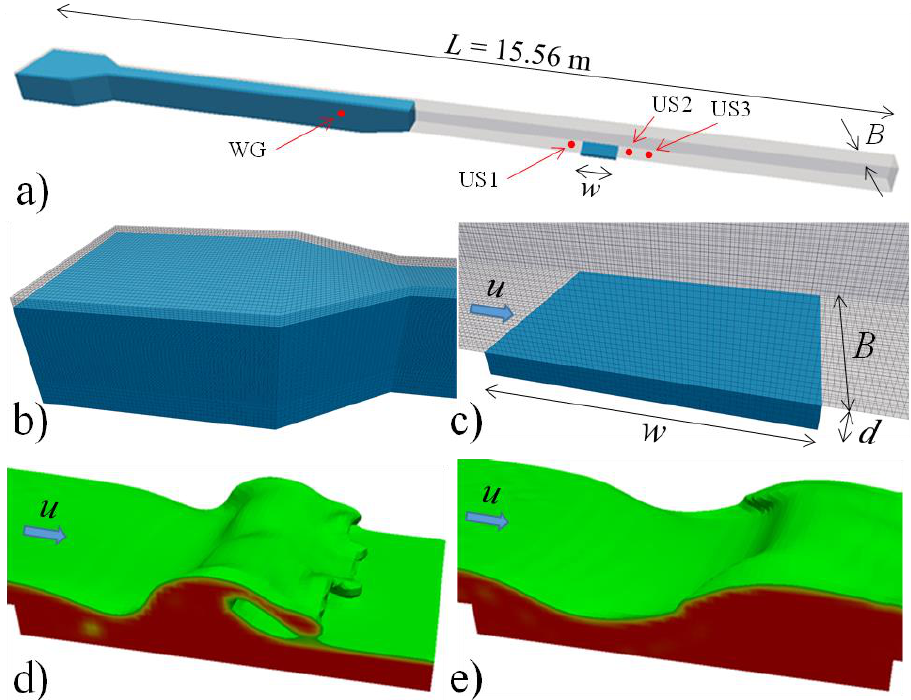
Figure 4. Computational domain and three-dimensional water surface profile: ( a ) computational domain of the full channel; ( b ) mesh resolution of the reservoir in the initial condition; ( c ) mesh resolution in the canal; ( d ) three-dimensional water surface profile at t ⁎ = 0.25 s; ( e ) three-dimensional water surface profile at t ⁎ = 0.5 s. t ⁎ is the time when the bore front reaches the canal.